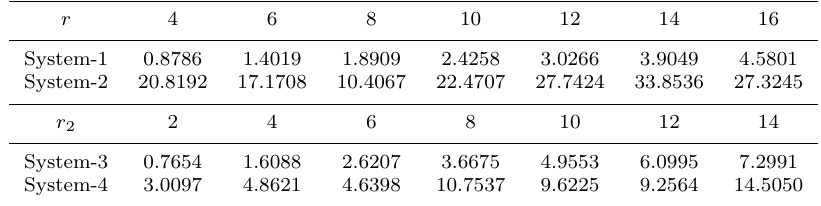
Algorithm 3 costs less time than Algorithm 2 to generate the reduced